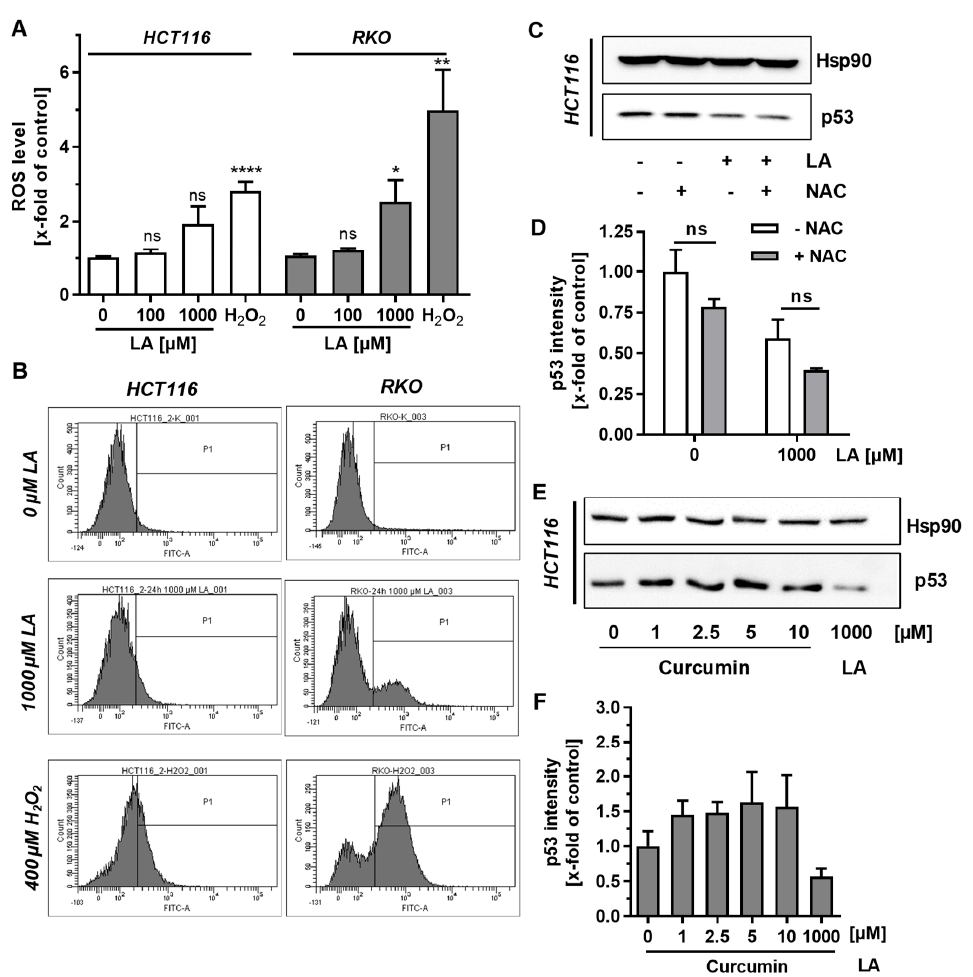
Figure 3. Induction of ROS upon LA treatment and impact of antioxidants on p53 depletion. ( A )